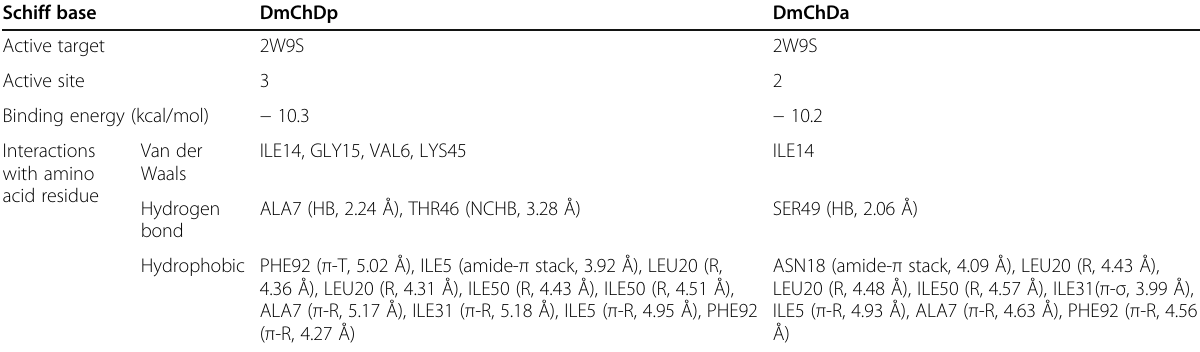
Table 4 Interactions of Schiff bases with amino acid residues of target proteins in S . aureus Schiff